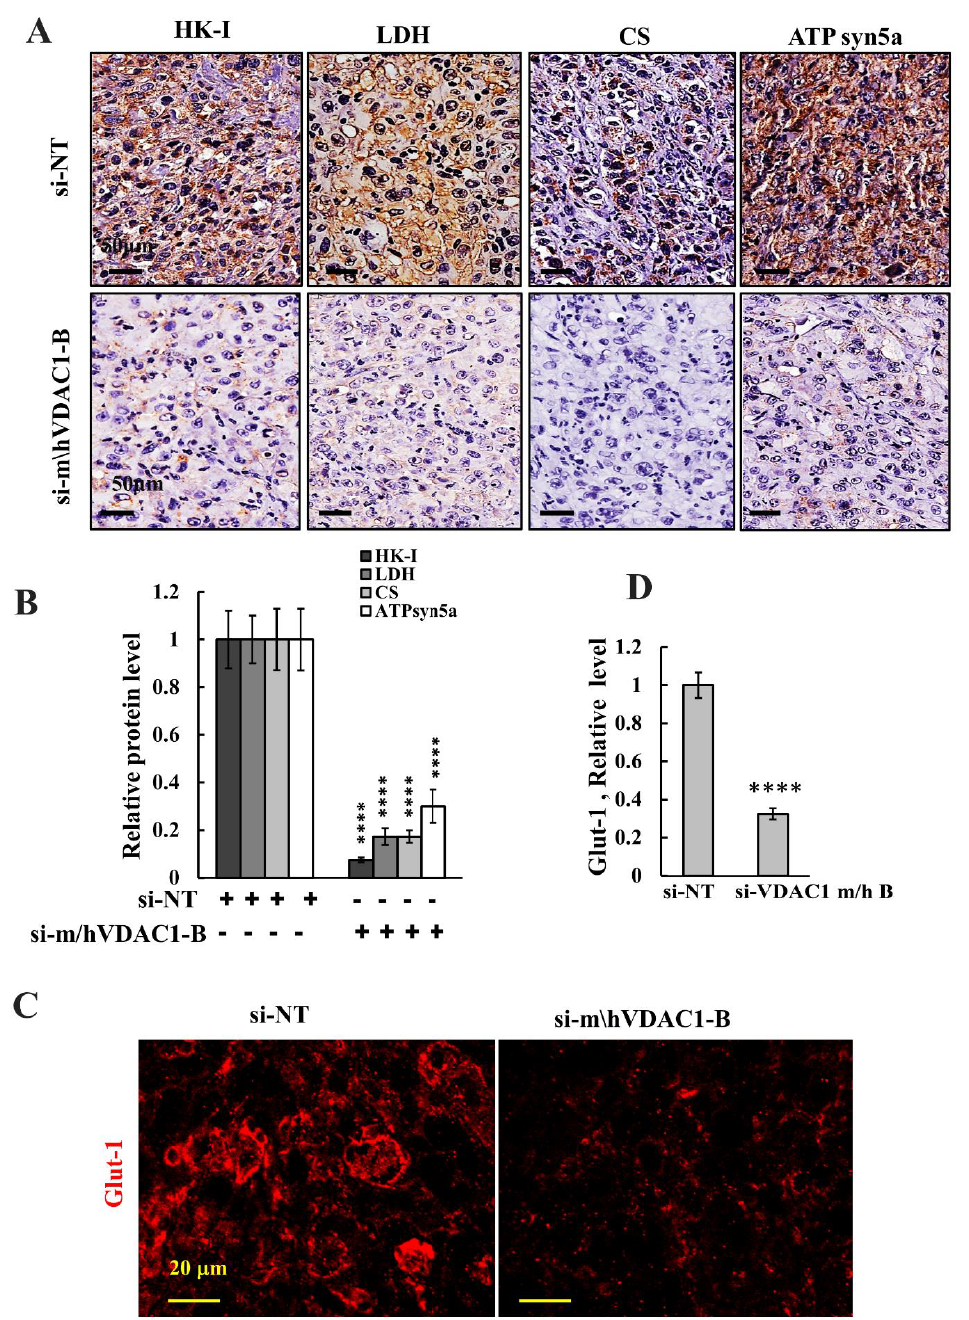
Figure 5. si-m/hVDAC1-B reduces the expression of metabolism-related enzymes. ( A , B ) Representative sections from si-m/hVDAC1B-treated or si-NT-treated H226-cell-derived tumors were IHC stained for HK-I, LDH, CS, and ATPsyn5a ( A ) and their quantification ( B ) . Tumor sections were also IF stained for Glut-1 ( C ) and its quantification ( D ). Results are the means ± SEM, (n = 3) **** p ≤